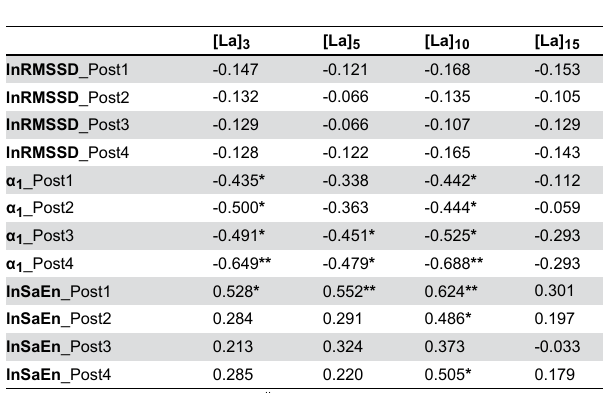
Table 5. Partial correlations, controlling for age, between lactate concentration and lnRMSSD, lnSaEn and α recovery.